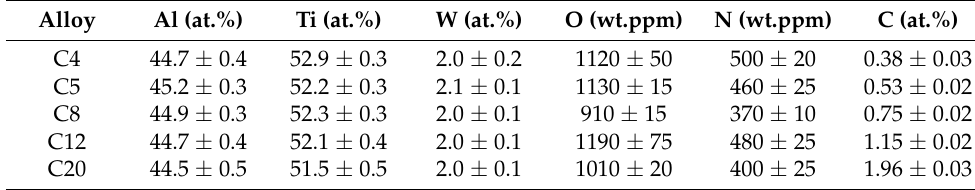
Table 1. Chemical composition of prepared alloys.